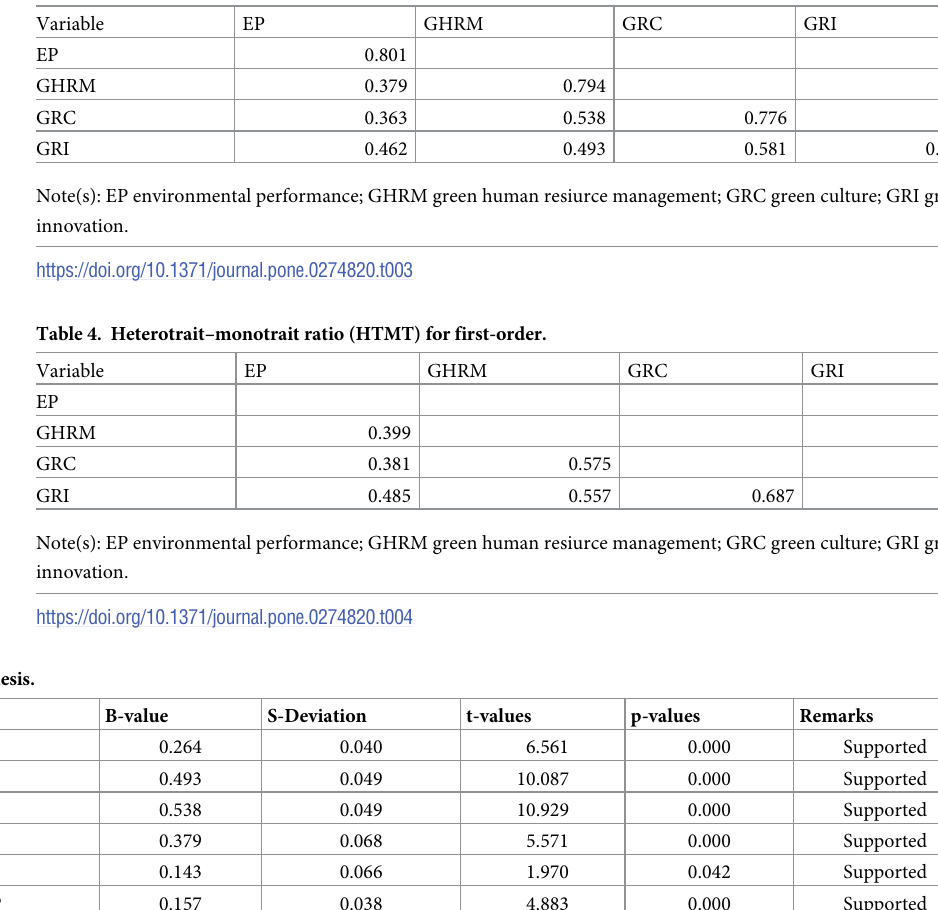
Table 3. Fornell–Larcker for discriminant validity.